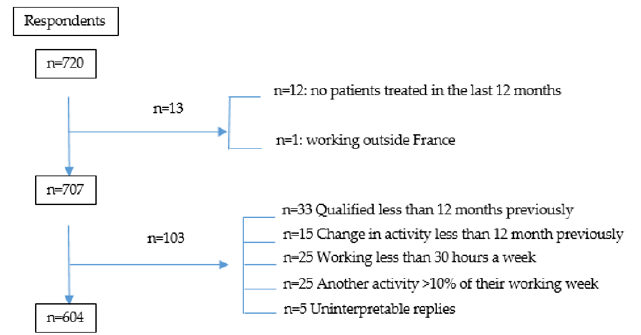
Figure 1. Study flow chart, describing the inclusion and exclusion of respondents.